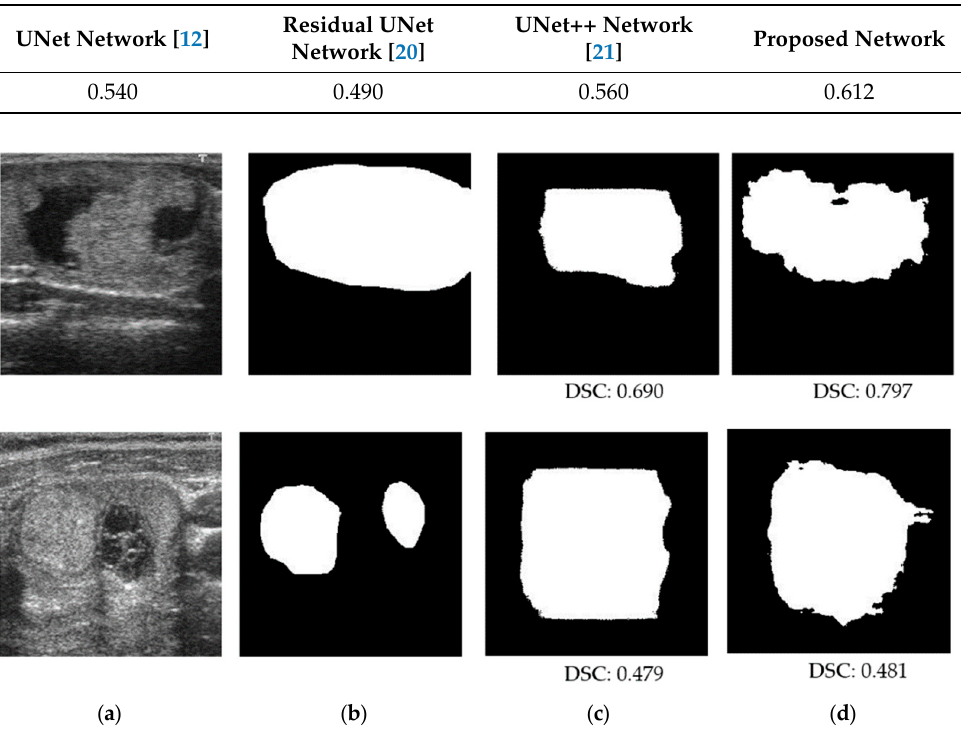
Table 8. Comparison of segmentation performance (DSC) between our proposed method and previous study on TDID dataset.